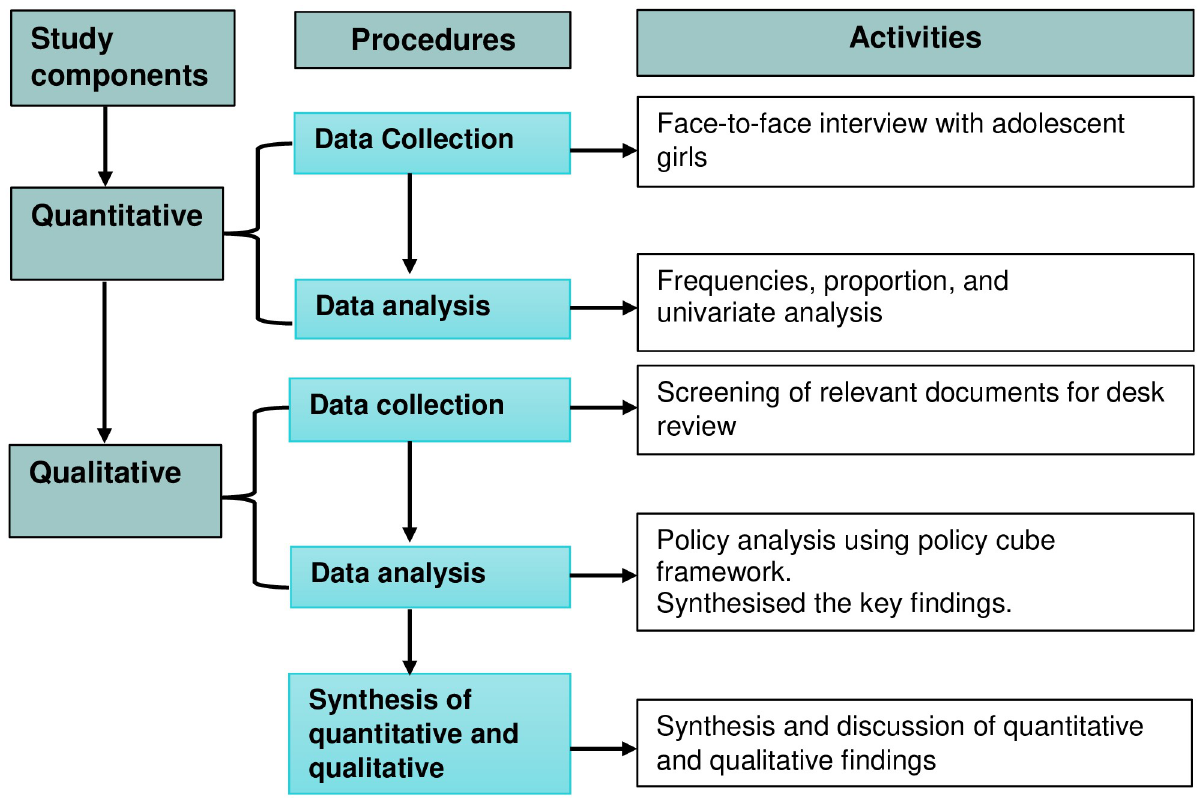
Fig 1. Flow chart of quantitative and qualitative components of the